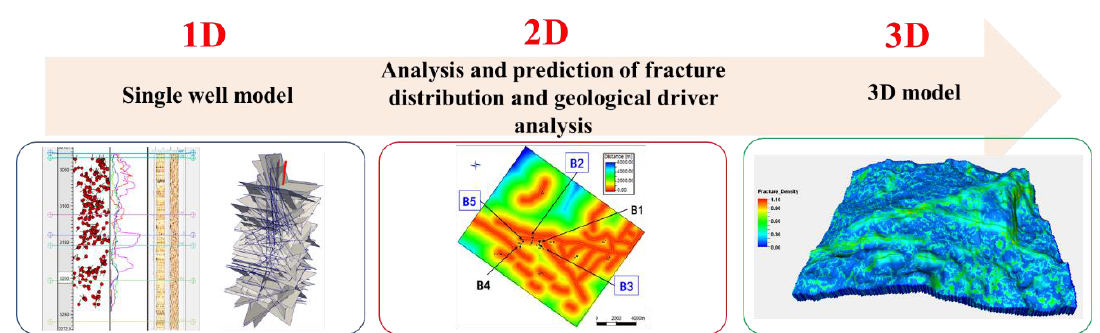
Figure 7. Progressive static model workflow employed to generate the fracture model.